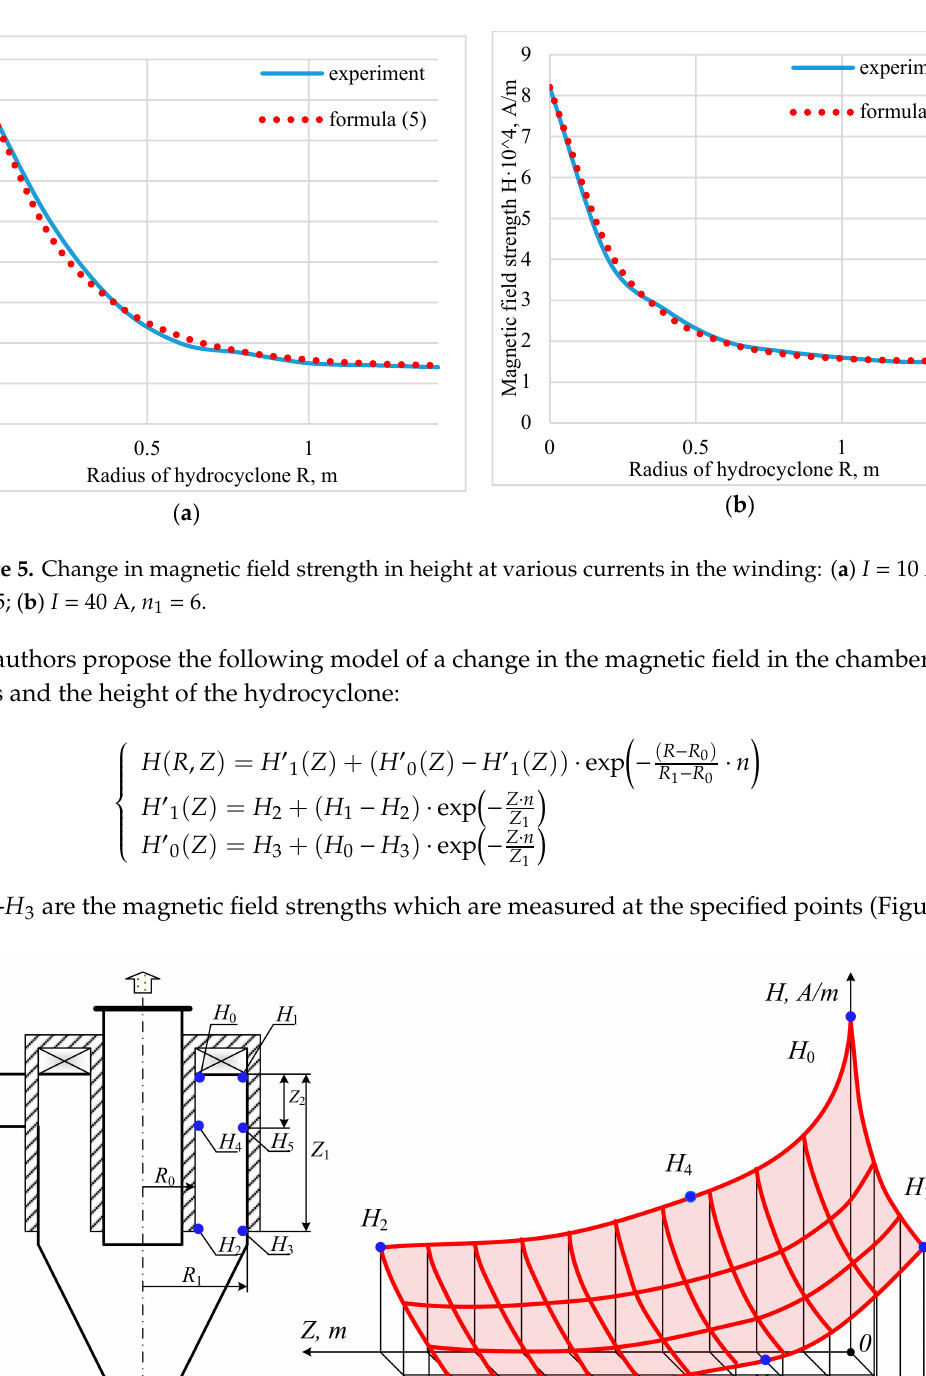
As an expression H ( Z ) the authors use the formula compiled by analogy with the previous: